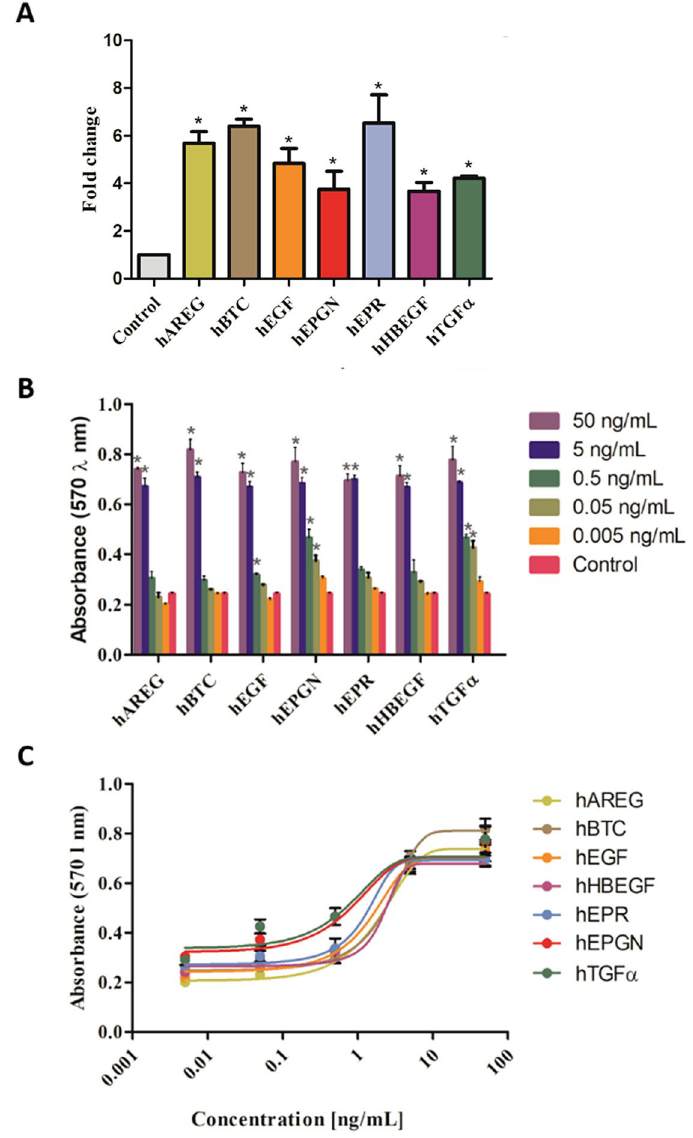
Figure 6. Activity of the seven EGF growth factors on cell proliferation. ( A ) Induction of HeLa cell proliferation by the seven EGF growth factors. Triplicates of HeLa cell cultures were treated with 50 ng/mL of each growth factor and the fold change of the proliferation rate relative to untreated cells (control) was determined after 48 h. The cells were quantified by flow cytometry and normalized using the CountBright™ Absolute Counting Beads method . * p < 0.05. ( B ) HeLa cell proliferation induced by the seven EGF growth factors as determined by the MTT assay. Triplicate cultures of HeLa cells were treated with the indicated amounts of the respective EGF growth factors for 48 h and quantified using the MTT assay. * p < 0.05. (C) Cell cultures absorbance as a function of the growth factor concentration. The mean values were derived from the assay described in (B) and curves were fitted with nonlinear